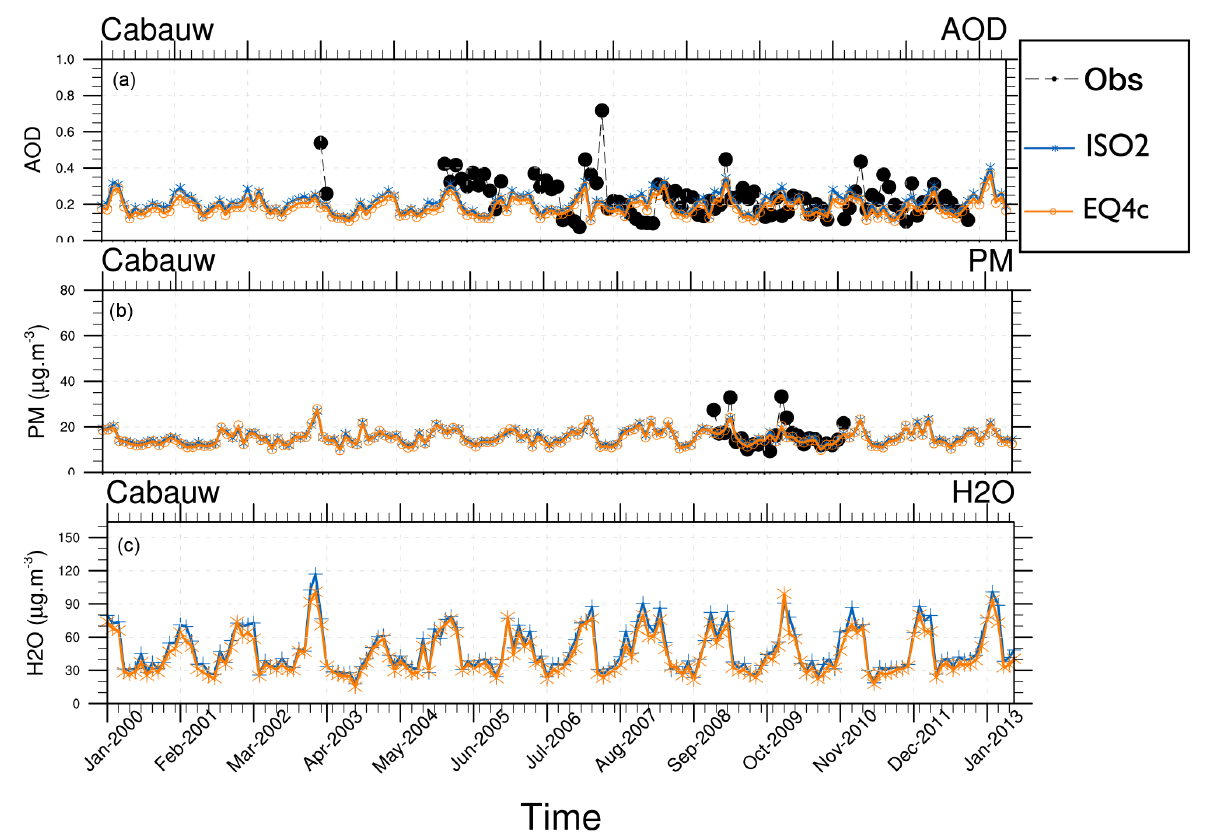
Figure 5. AOD (a) , total (liquids and solids) particulate matter (PM) (b) , and aerosol associated water (c) at EMEP station Cabauw for 2000– 2013 (monthly means): ISORROPIA II (ISO2), EQSAM4clim (EQ4c), and AERONET observations (black circles). Available observations are shown. Additionally, various size-resolved aerosol properties are shown in the Supplement (Fig.